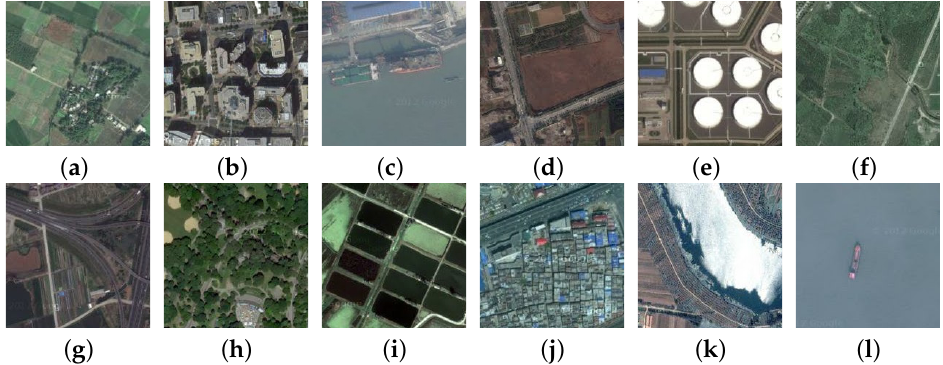
Figure 7. Example images in 12 categories in the SIRI-WHU dataset. ( a – l ) Agriculture, commercial, harbor, idle land, industrial, meadow, overpass, park, pond, residential, river and water,